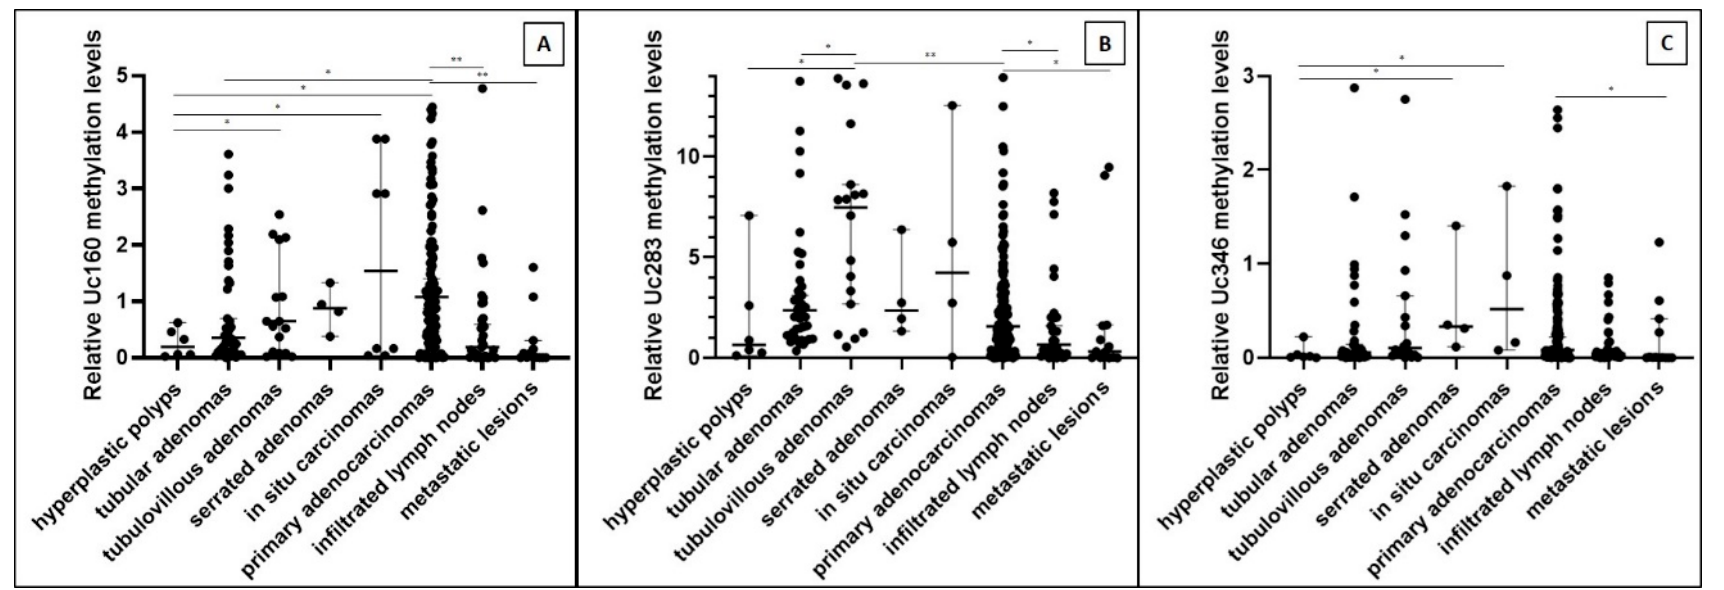
Figure 1. Relative tissue methylation levels of Uc160 ( A ), Uc283 ( B ), and Uc346 ( C ) in benign and malignant lesions and metastatic lesions (hyperplastic polyps, di ff erent types of adenomas, adenocarcinomas, infiltrated lymph nodes, and metastatic lesions; median values with 95% CI). * p < 0.05, ** p <